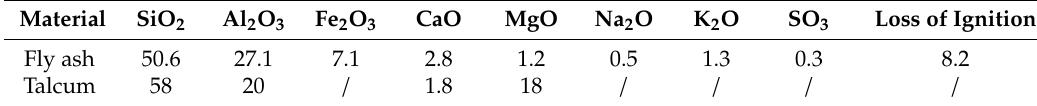
Table 1. Chemical composition of ceramic raw materials.